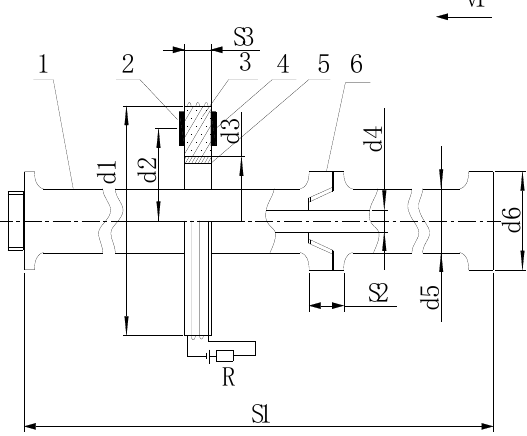
Figure 12. Installation of the detection device: 1—drill stem; 2—magnetoresistive sensor B; 3—current coil; 4—magnetoresistive sensor A; 5—plastic tube; 6—drill-stem joint.